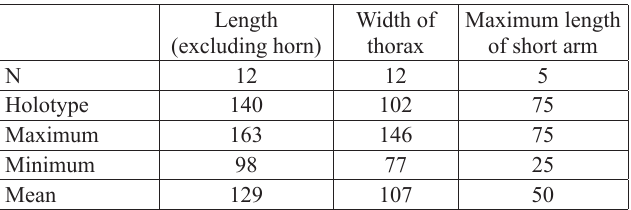
Table 4. Dimensions (in μ m) of Ares rettensteinensis Cifer sp. nov. N, number of specimens